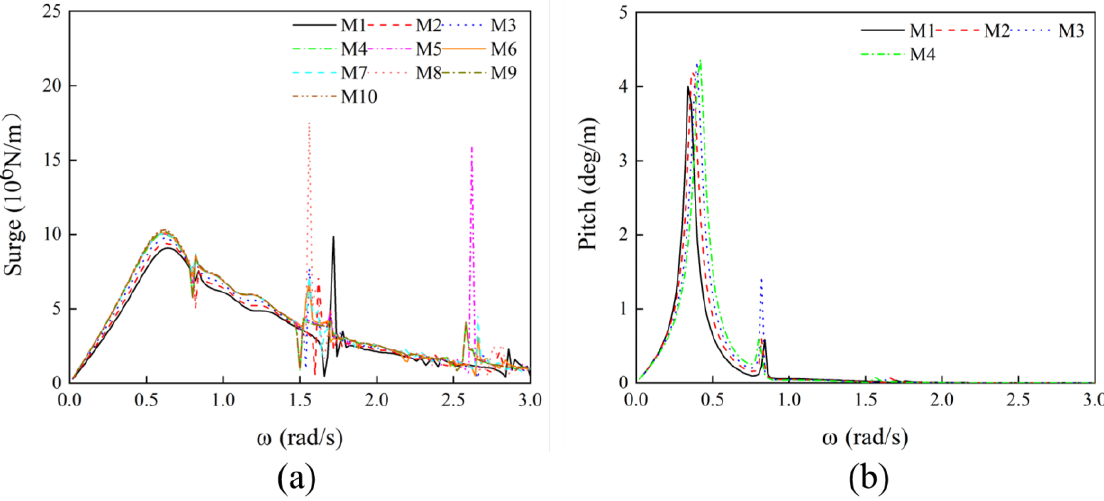
Figure 4. Hydrodynamic analysis results: ( a ) comparison of first-order wave exciting force per unit wave amplitude in surge for various platform dimensions; ( b ) comparison of pitch RAOs for various platform dimensions.